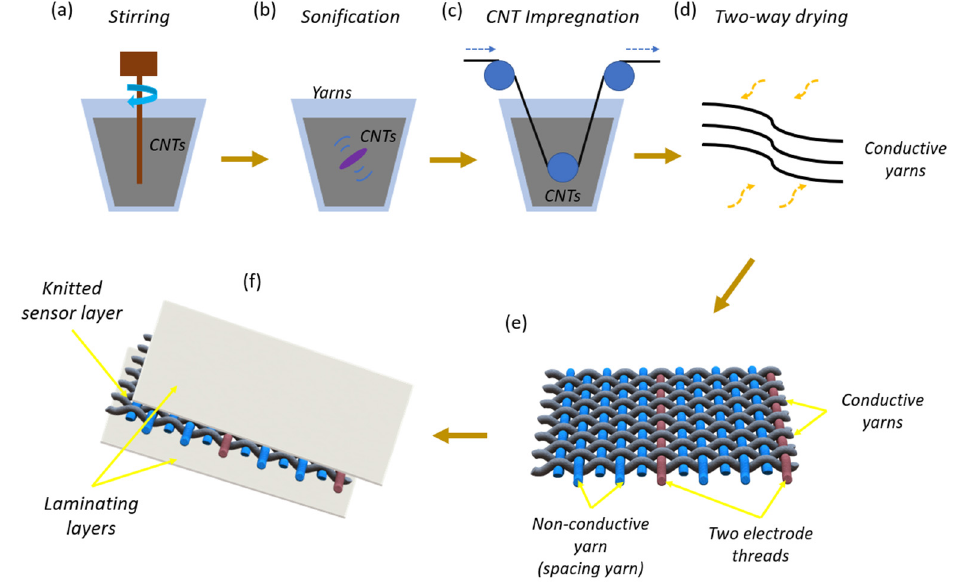
Figure 1. Fabrication process of conductive yarns consisting of ( a ) stirring CNTs, ( b ) sonification CNTs, ( c ) CNT-impregnation yarns, ( d ) drying CNT-yarns, ( e ) weaving sensor layer, and ( f ) the sensor with two laminating layers.